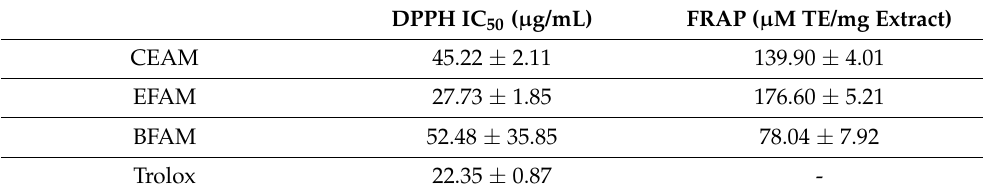
Table 3. Antioxidant activity of the different fractions of A. maurorum using DPPH and FRAP